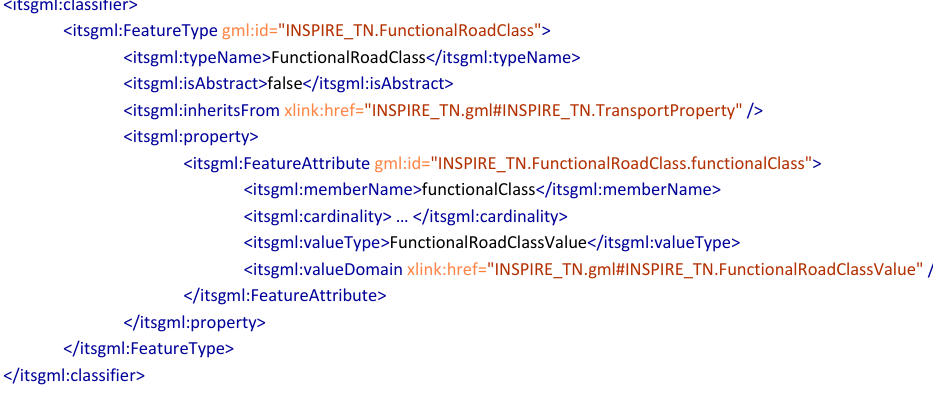
Figure 9. INSPIRE SpeedLimit and FunctionalRoadClass.